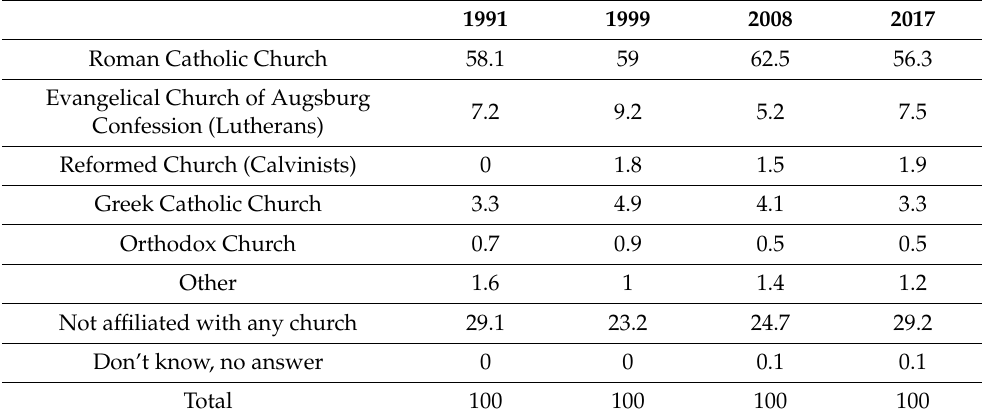
Table 2. Proportion of those affiliated to a church in Slovakia in EVS surveys (in